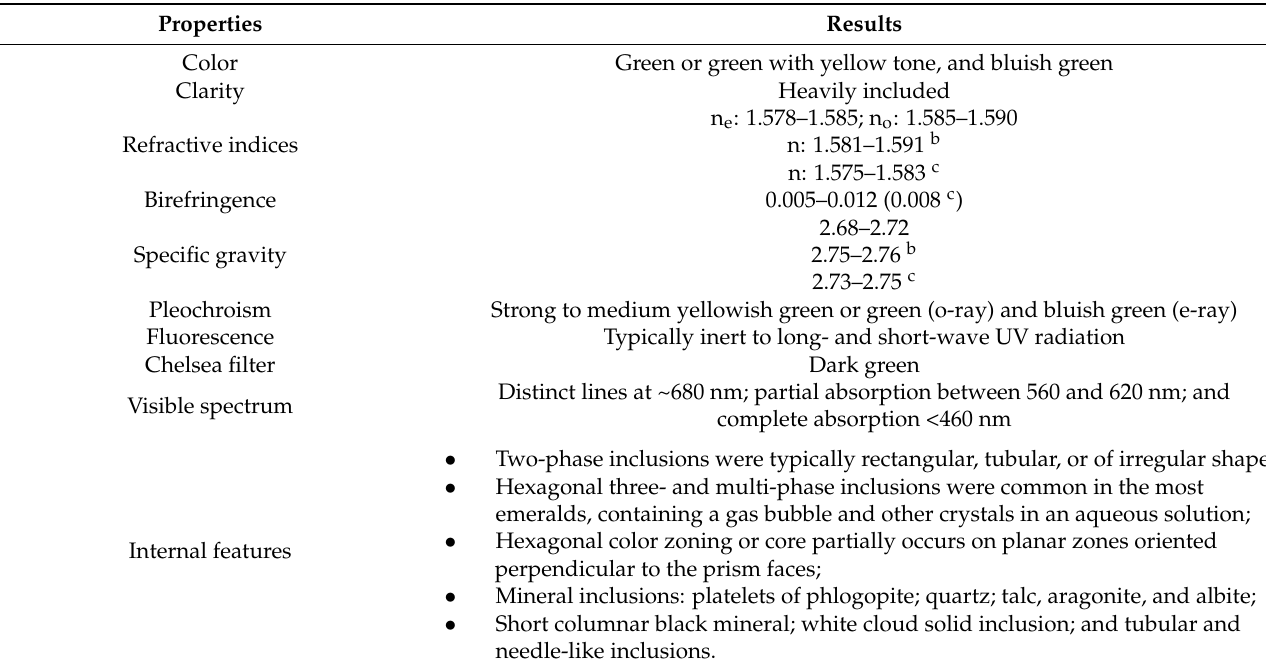
Table 1. Gemological properties of emeralds from